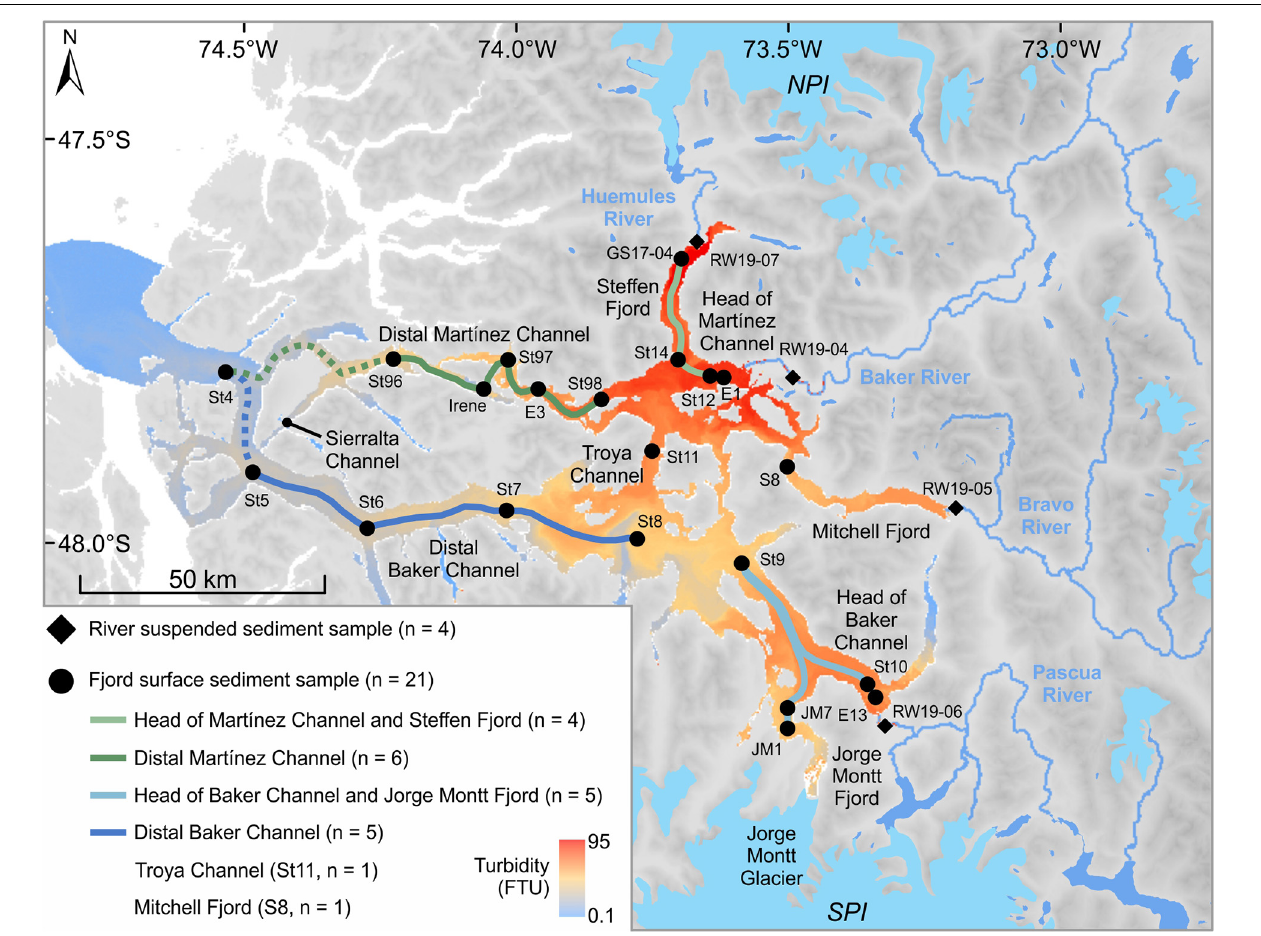
FIGURE 2 | Location of the fjord surface sediment samples in the Baker-Martínez fjord system and of the river suspended sediment samples collected in the four main rivers that discharge into the fjord system. The fjord surface sediment dataset ( n = 21) is split into six subsets based on sample location. The colored lines connecting the fjord samples represent the four subsets of the fjord sample dataset with n > 1. Note that sample St4 is located downstream of the confluence of Baker and Martínez channels, and thus belongs to both the distal Baker Channel and distal Martínez Channel datasets (stippled lines). The background turbidity data is derived from Landsat 8 satellite images from 08-01-2016 and 31-01-2016 (satellite data source: USGS) by the International Initiative on Water Quality (2019). See Table 2 for the exact location of the sampling sites.